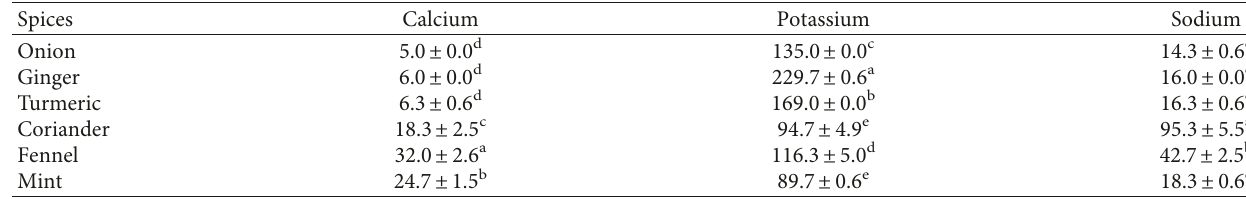
Table 2: Mineral composition of spice powders on dry weight basis (mg/kg − 1 ).